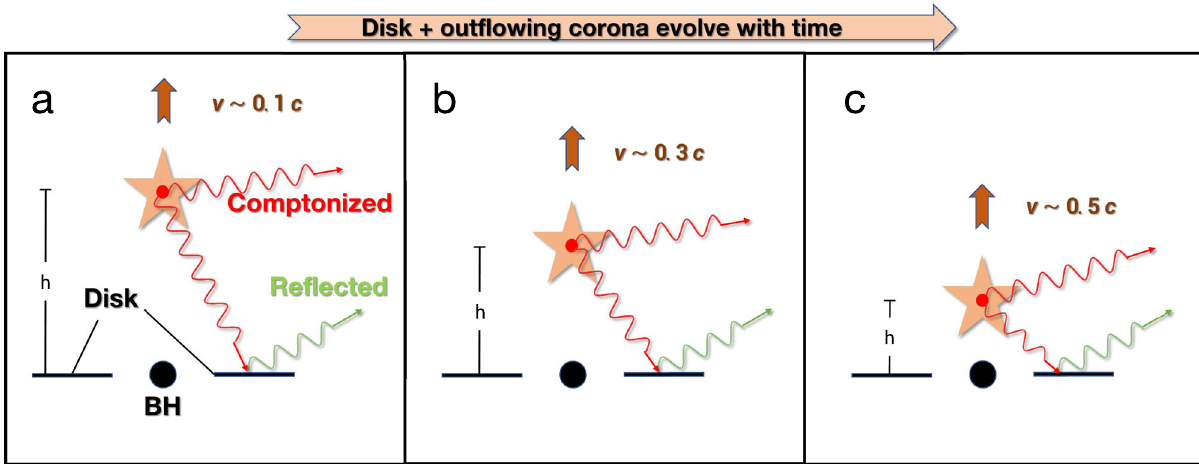
Fig. 5 Schematic of the proposed jet-like corona in the decay phase. ’ BH ’ stands for Black Hole, and the symbol `star ’ represents the coronal region where the X-ray radiation comes from. The corona at height h can be understood as a standing shock where the material fl owing through. The Comptonized hard photons (red arrow) from the corona illuminates the accretion disk, resulting in the observed re fl ection component (green arrow). Panel a , b and c , represents the peak, middle and end of the decay phase, respectively. As the corona contracts towards the black hole (e.g., from panel a to b ) with decreasing height, the fi tted re fl ection fraction decreases, which suggests that the bulk motion of the out fl owing coronal material (sketched as an upward arrow) gets faster in the deeper gravitational potential well, with the increase of the out fl owing velocity ν in units of light speed c . Note that the values of ν are not taken from the spectral fi ts, but for the sake of depicting faster out fl owing